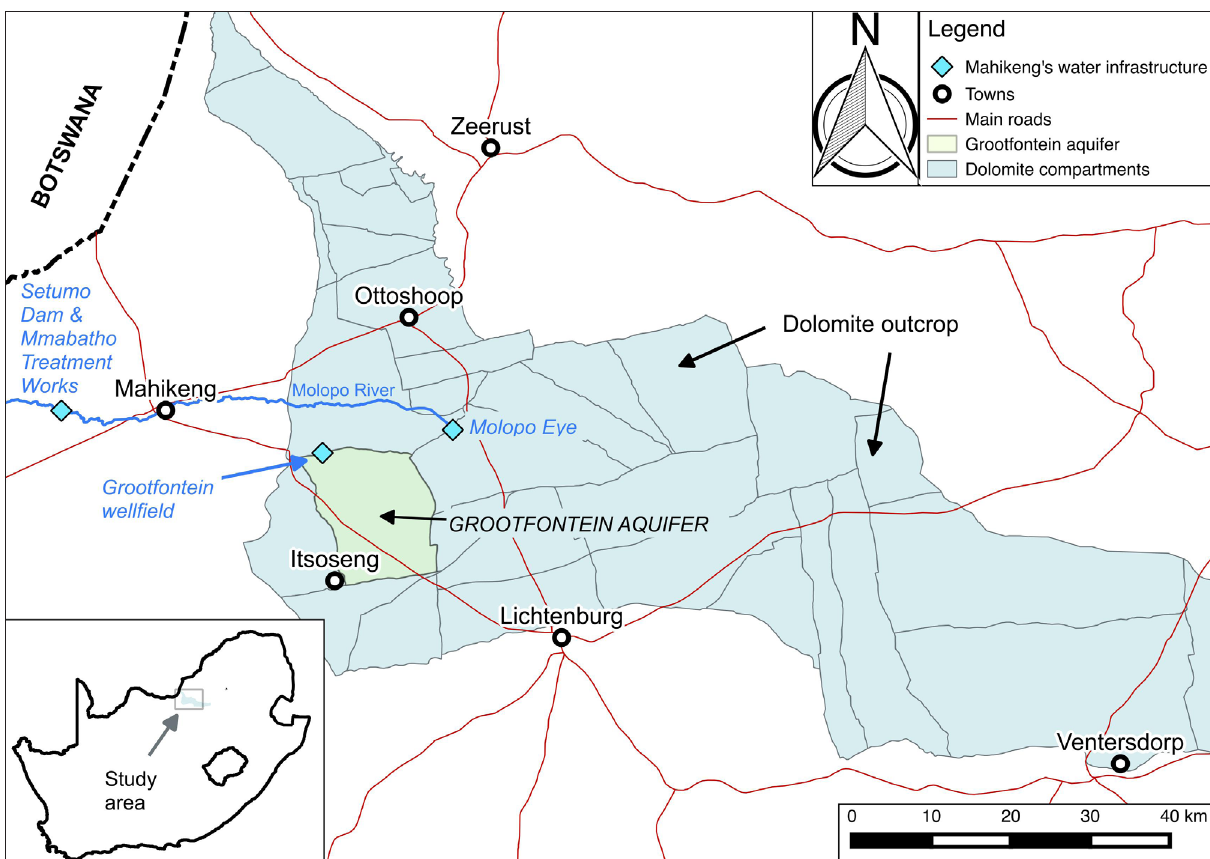
Figure 1: The Grootfontein aquifer and the dolomite outcrop near Mahikeng (boundaries after Holland and Wiegmans 14